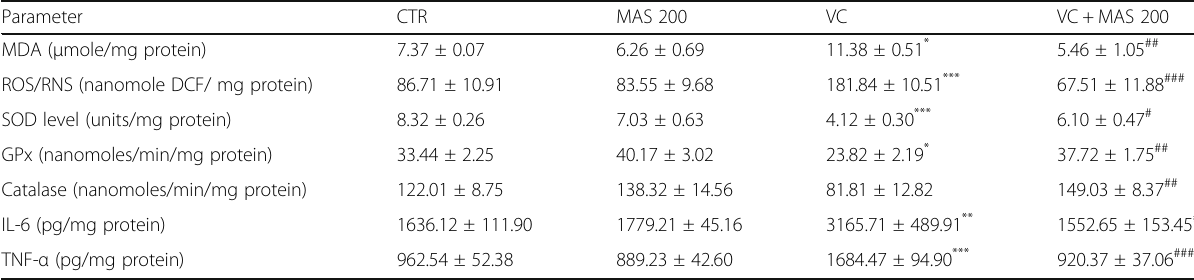
Data are presented in mean±SEM. The differences were tested by one-way ANOVA followed by Tukey ’ s post hoc test; n =10 for each group. * Significant at P < 0.05; ** Significant at P <0.01; *** Significant at P <0.001- versus CTR group; # Significant at P <0.05; ## Significant at P <0.01; ### Significant at P <0.001- versus VC group. CTR control, MAS 200 MAS 200mg/kg p.o., VC varicocele, VC+MAS 200 MAS 200mg/kg p.o., MDA Malondialdehyde, ROS/RNS reactive oxygen species/ reactive nitrogen species, SOD superoxide dismutase, GPx glutathione peroxidase, IL-6 interleukin-6, TNF- α tumor necrosis factor- α , p.o. per oral, ANOVA analysis of variance, SEM standard error of the